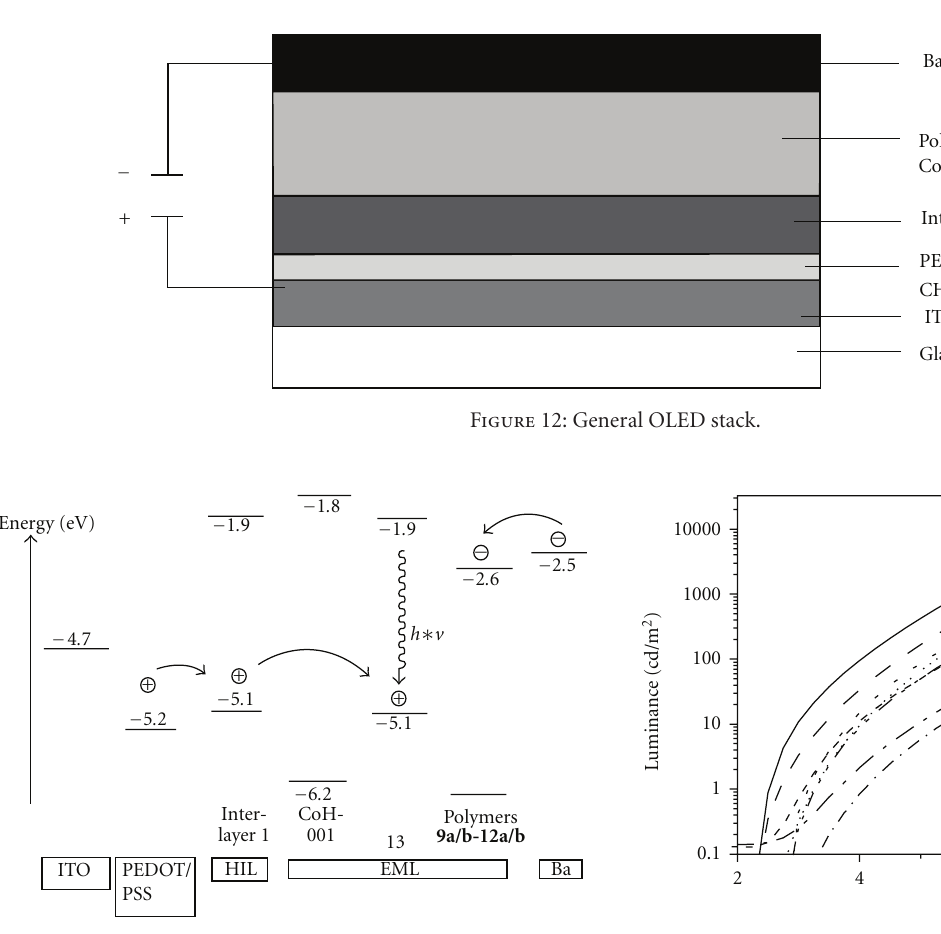
Figure 13: Energy levels of the used blend materials in the OLED stack.